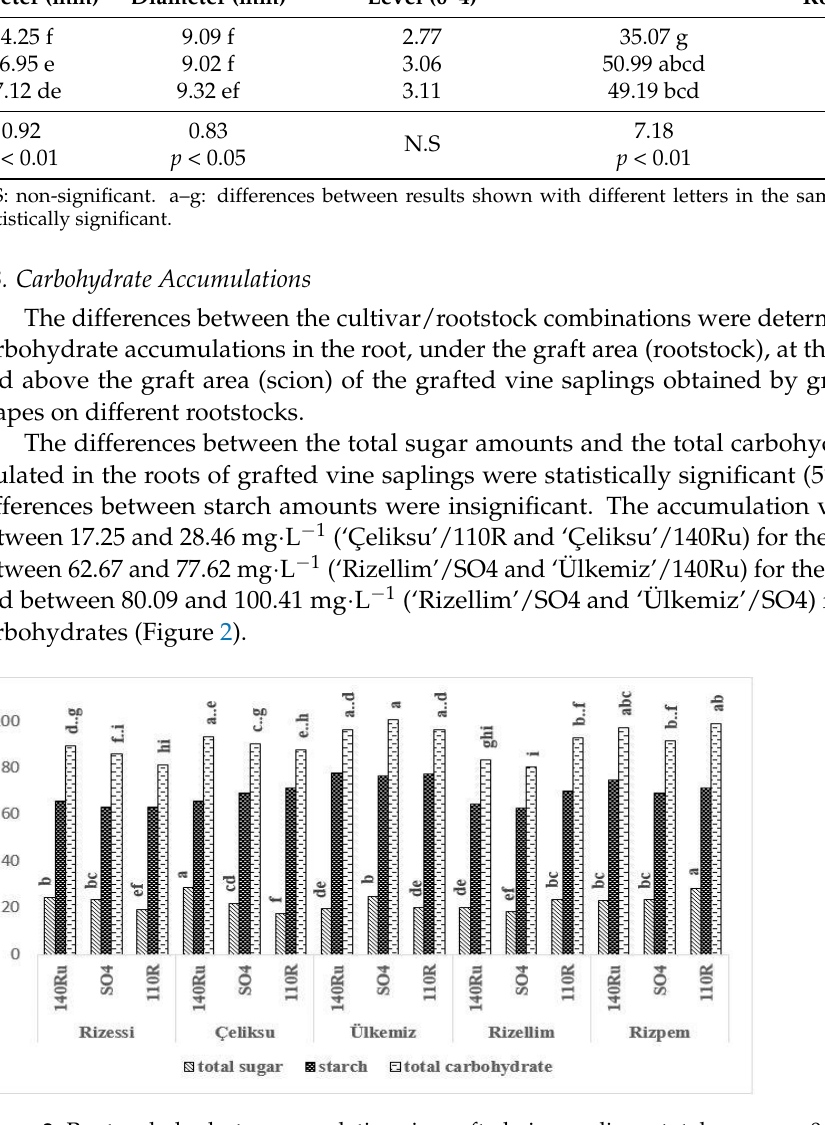
Figure 2. Root carbohydrate accumulations in grafted vine saplings. total sugar p < 0.01 LSD: 2.20,